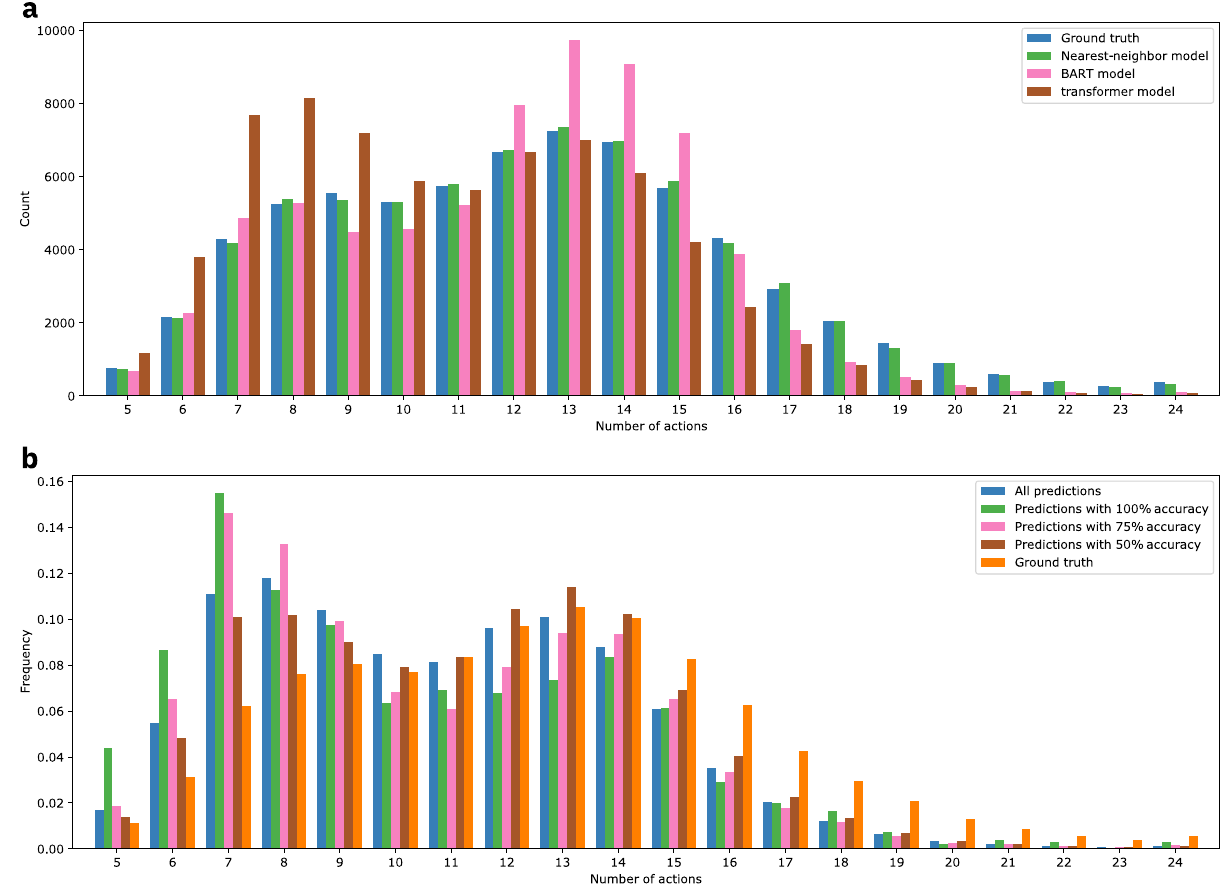
Fig. 4 Distributions of the lengths of predicted action sequences. a Comparison of the lengths of predicted action sequences for the different models. b Comparison of the lengths of predicted action sequences for different levels of